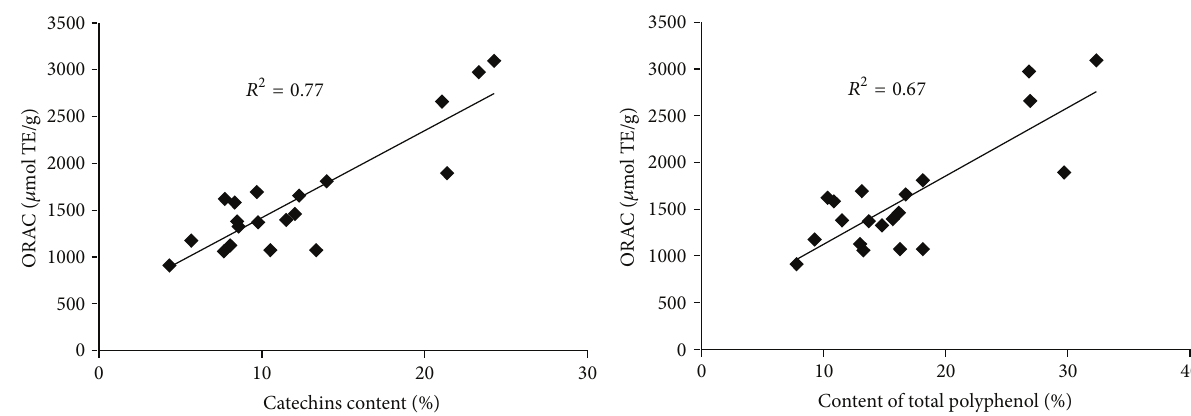
Figure 5: Correlation analysis of ORAC values against total polyphenols and catechins in tea.